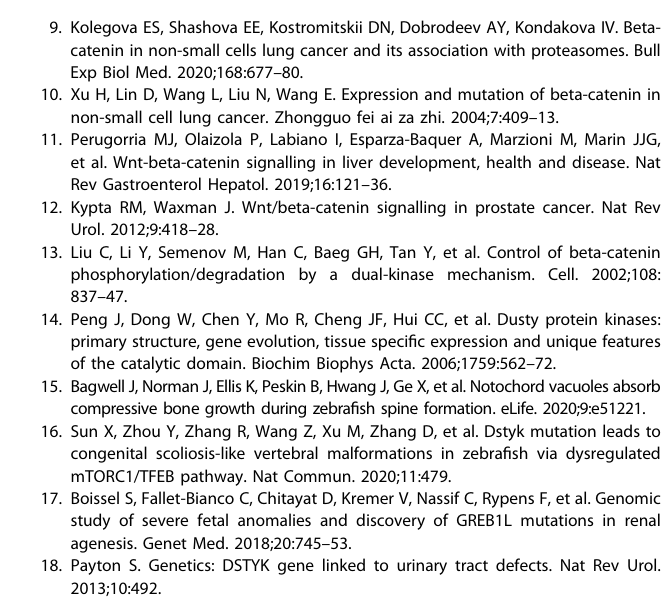
DATA AVAILABILITY The datasets used and analyzed during the current study are available from the corresponding author on reasonable request.